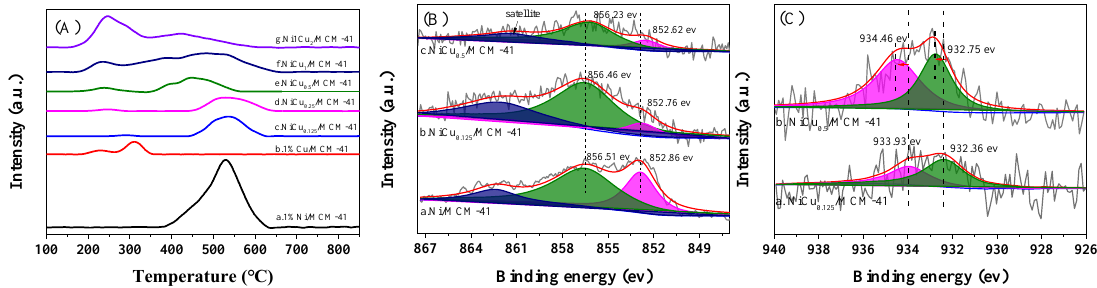
Figure 5. ( A ) H 2 -TPR profiles of the catalysts. ( B ) Ni2p 3/2 XPS spectra of the catalysts. ( C ) Cu2p 3/2 XPS spectra of the catalysts.